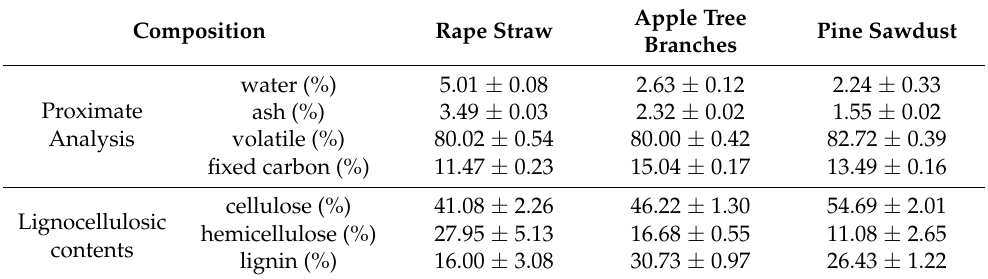
Table 1. The basic composition of samples ( n =